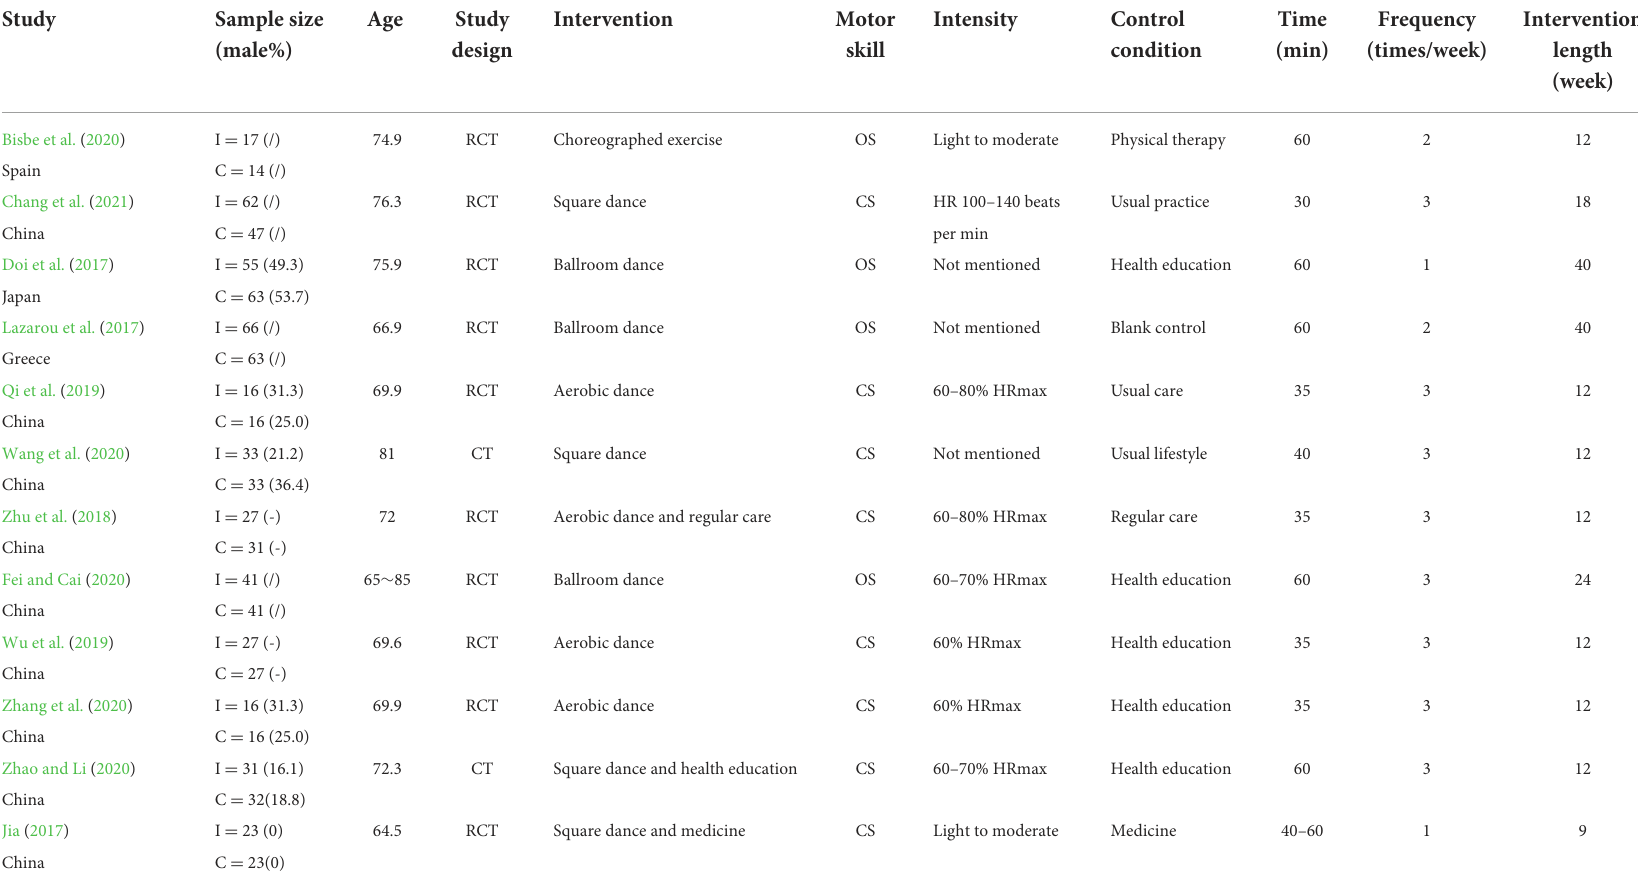
TABLE 1 General characteristics of the included